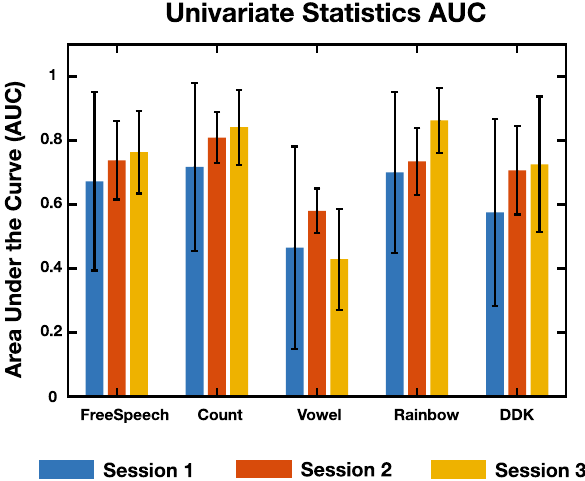
Figure 2. Model performance using low-level acoustic features. AUC scores from models created using univariate statistics of acoustic and articulatory features. The different bars in each task represent which of the recording days was used in the test data set. Overall, for most tasks, performance increased on predicting COVID-19 status on subsequent days of recording. Statistics derived from the Count task appear to outperform the other tasks when used in a predictive model. Error bars are the standard deviation of the statistic across all bootstrap iterations.